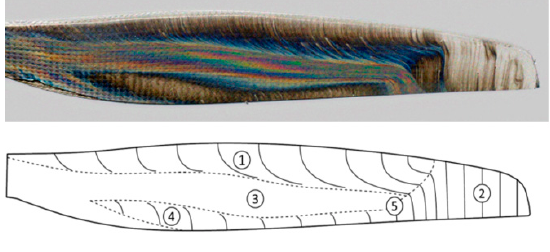
Figure 1. (top) Interference image; (bottom) derived oil-flow topology, rotor R17x5.7, f 3 = 100 Hz.